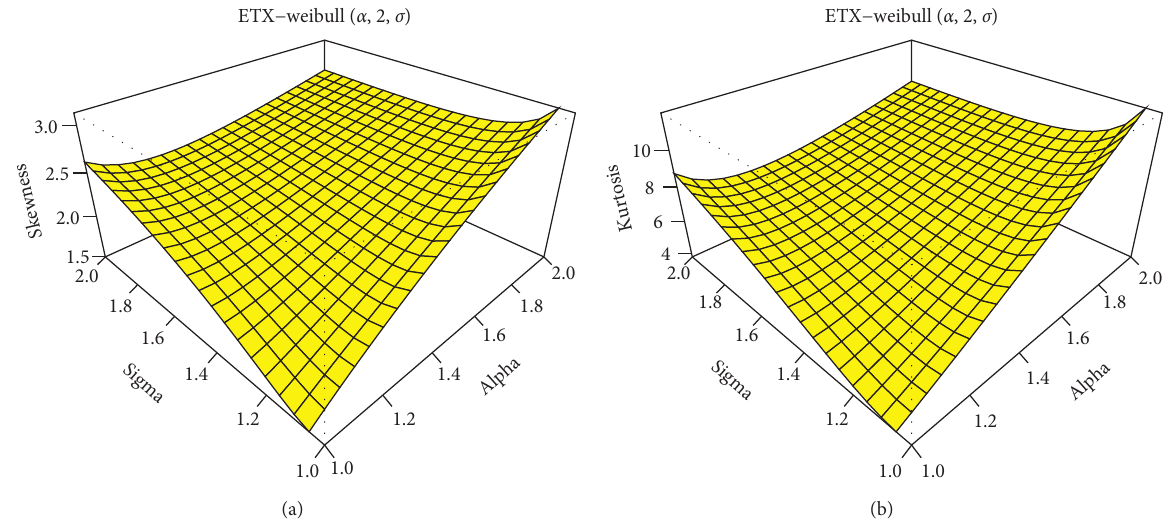
Figure 2: Plots of the skewness and kurtosis of the ETX-Weibull model.